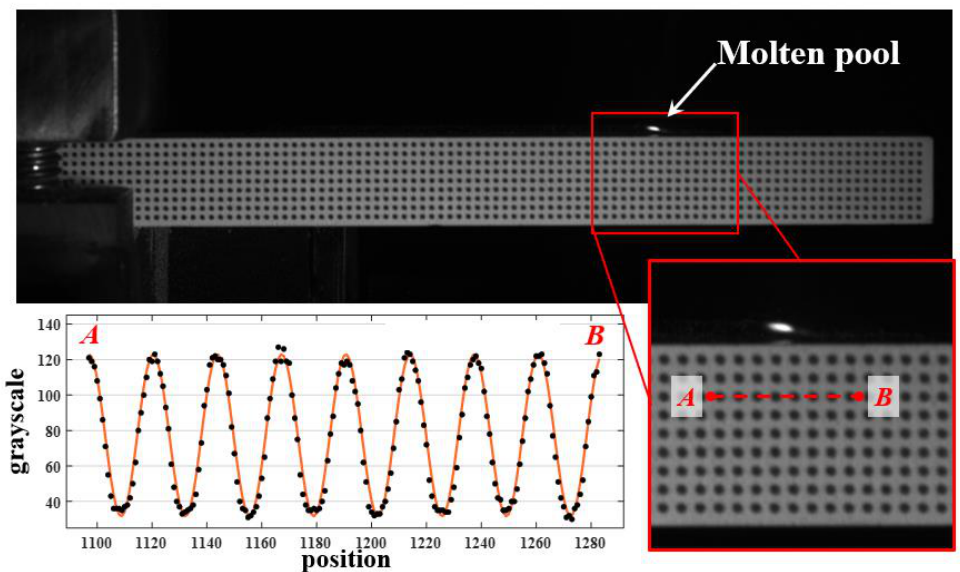
Figure 7. Orthogonal grid lines photographed during repair. Gray value in line segment AB coincides well with the sinusoidal curve.